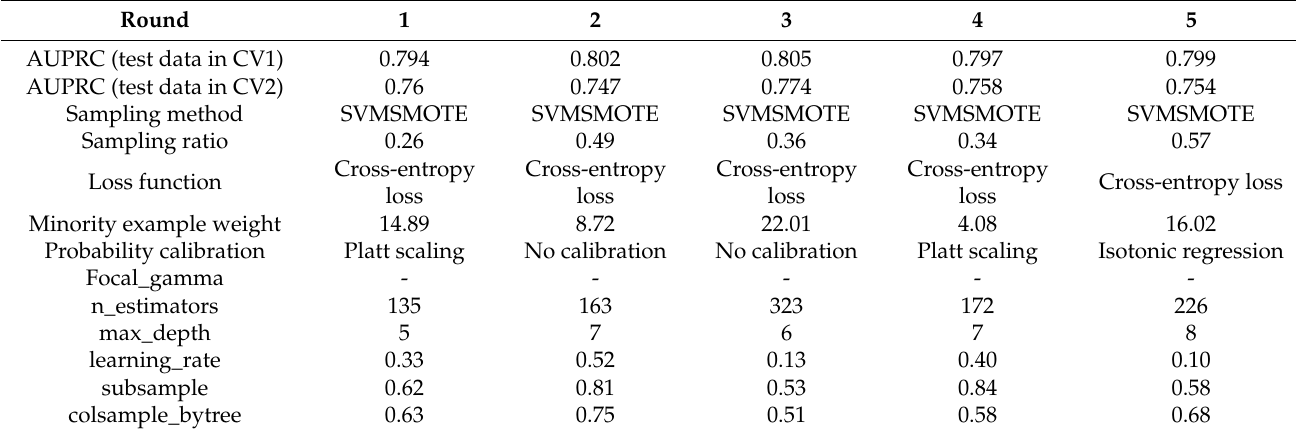
Table 2. Five different sets of AutoML results.